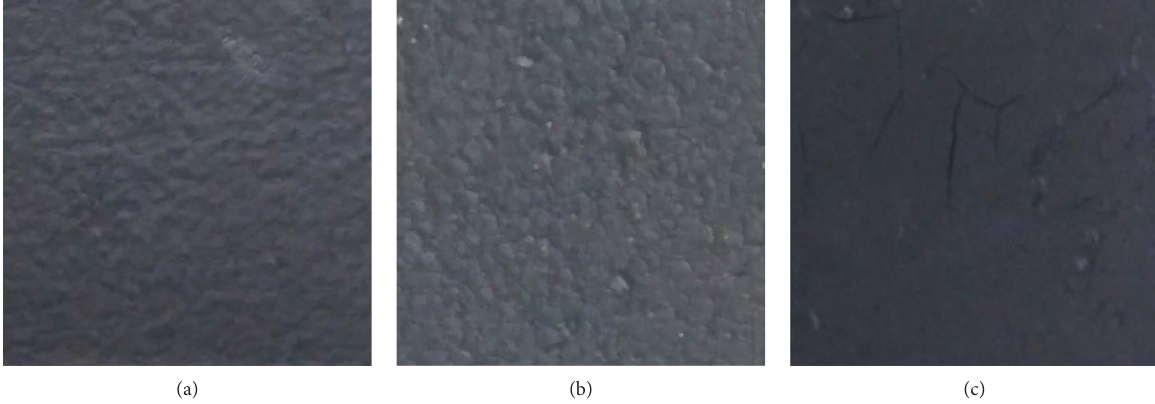
Figure 9: Photographs of the surface of the electrode-coated CI-IPA (1/1) (a), CI-IPA (1/0.5) (b), and CI-IPA (1/2) ink (c).